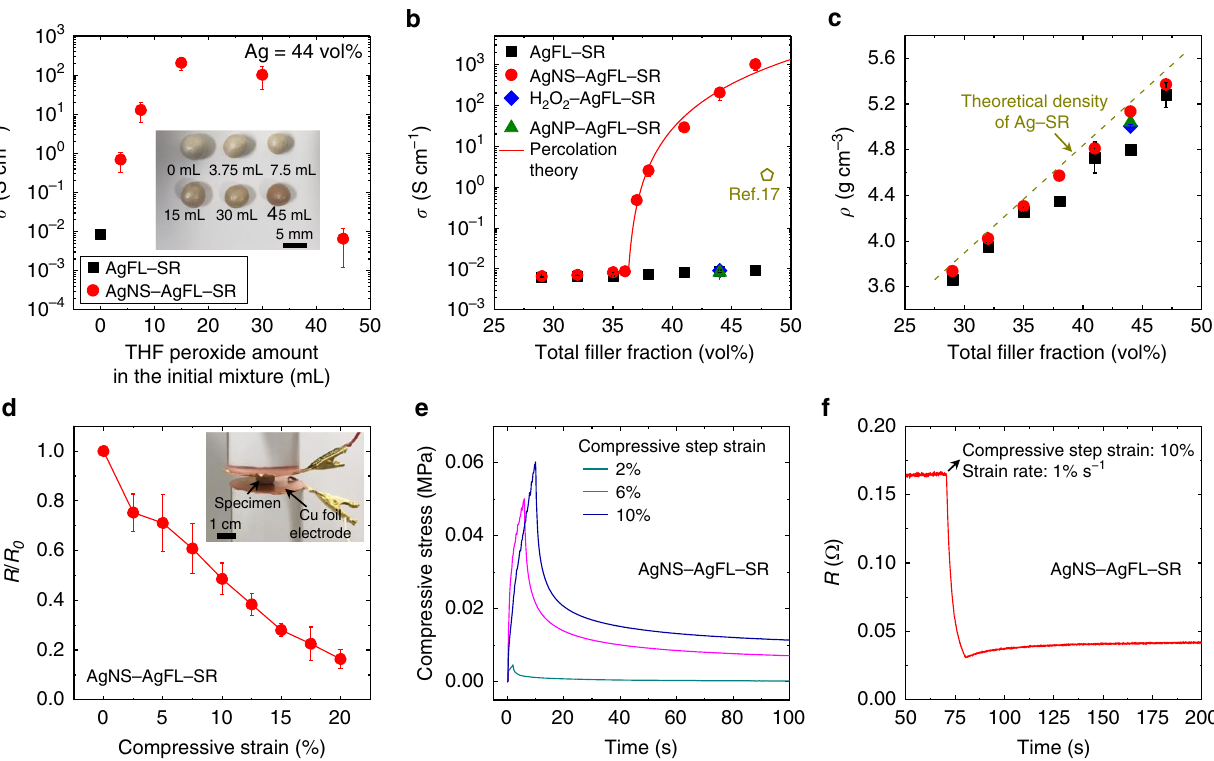
Fig. 3 Electrical transport property of the AgNS-AgFL-SR nanocomposite. a The electrical conductivity of the AgNS-AgFL-SR nanocomposite as a function of THF peroxide amount in the initial mixture. The error bars represent the standard deviation of the data. The Ag fi ller fraction was fi xed at 44 vol %. Optical images of the nanocomposites are provided in the inset. b , c The electrical conductivity and density of the AgNS-AgFL-SR nanocomposites are compared with those of control specimens as a function of the total Ag fi ller fraction. The density was measured by the Archimedes method. The amount of THF and THF peroxide was fi xed at 15 mL. The electrical conductivity of the graphite-incorporated healable viscoelastic nanocomposite is also compared 17 . The error bars represent the standard deviation of the data. d The normalized resistance of the AgNS-AgFL-SR (Ag = 44 vol%, THF peroxide = 15 mL) nanocomposite as a function of compressive strain. The error bars represent the standard deviation of the data. The resistance was measured in steady state after relaxation at each strain. The inset image shows the measurement setup. e, f The mechanical stress and electrical resistance relaxation of the AgNS-AgFL-SR (Ag = 44 vol%, THF peroxide = 15 mL) nanocomposite after compressive step strain (strain rate = 1% s − 1